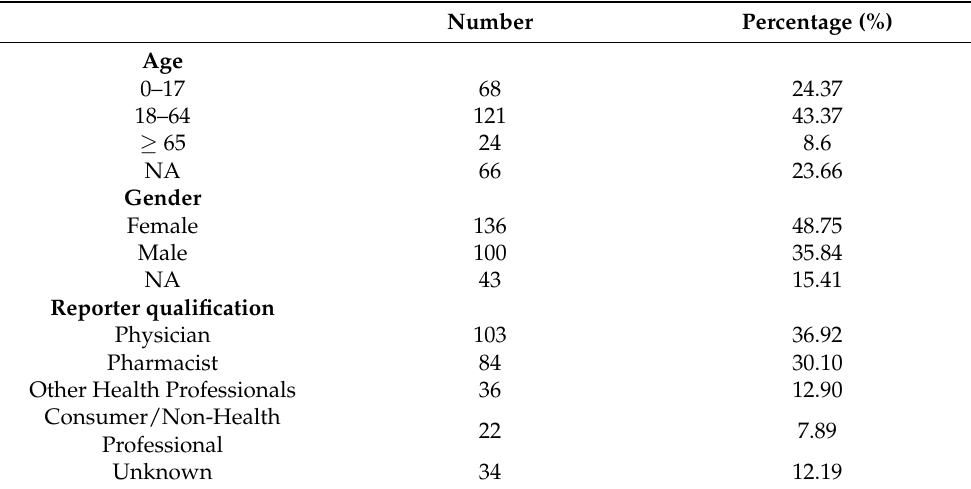
Table 1. Demographics and general characteristics of antimicrobial-related ADEs in individuals ( n = 279).